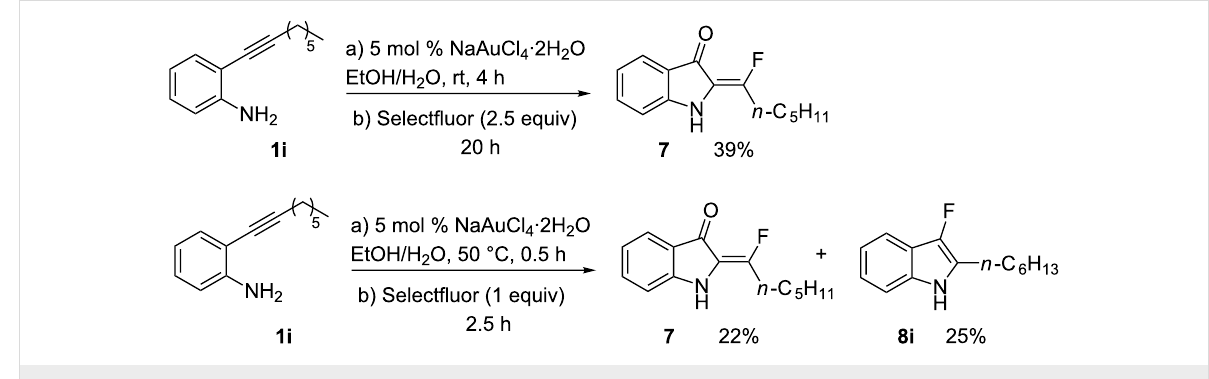
Scheme 3: Reaction on n -hexyl-substituted derivative 1i